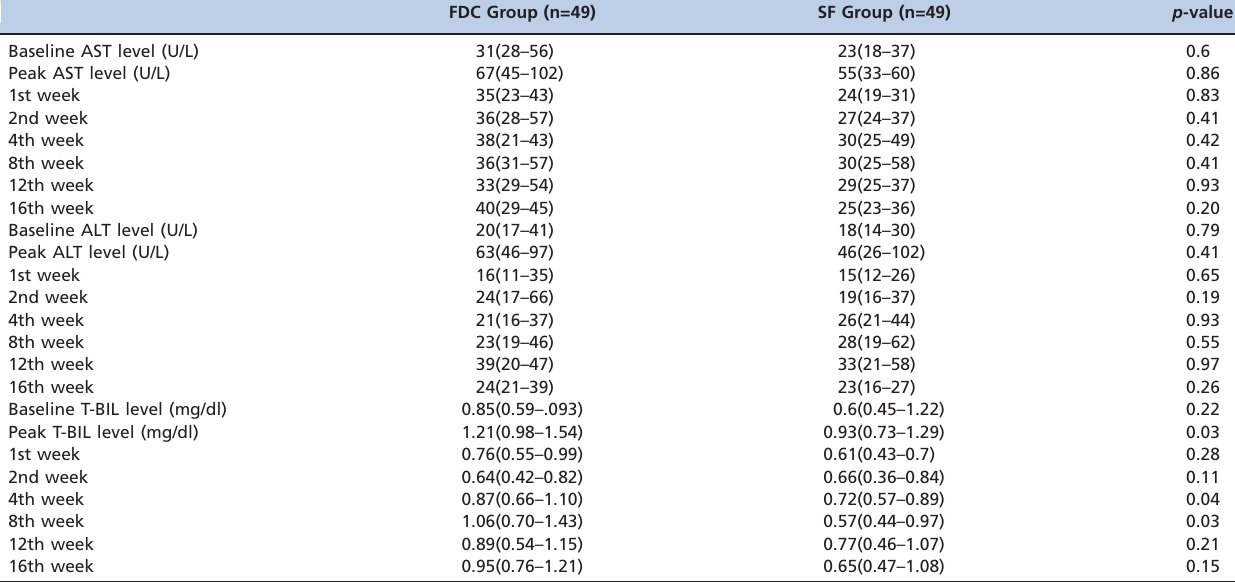
Table 3 - Liver function tests in the PP population during anti-TB drug treatment.